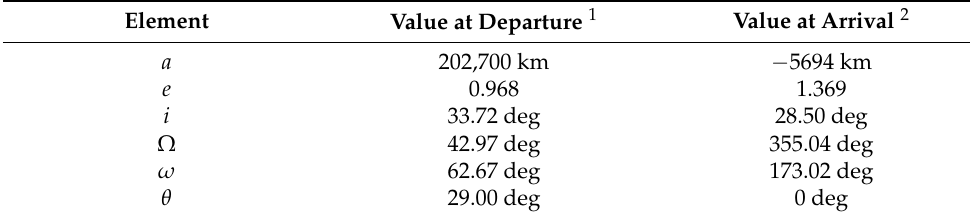
Table 4. Orbital elements of the departure trajectory.